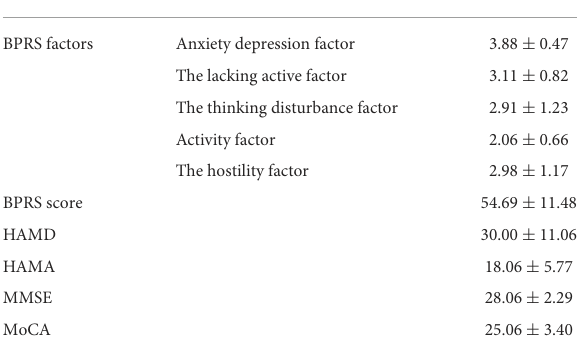
TABLE 3 Neuropsychological rating